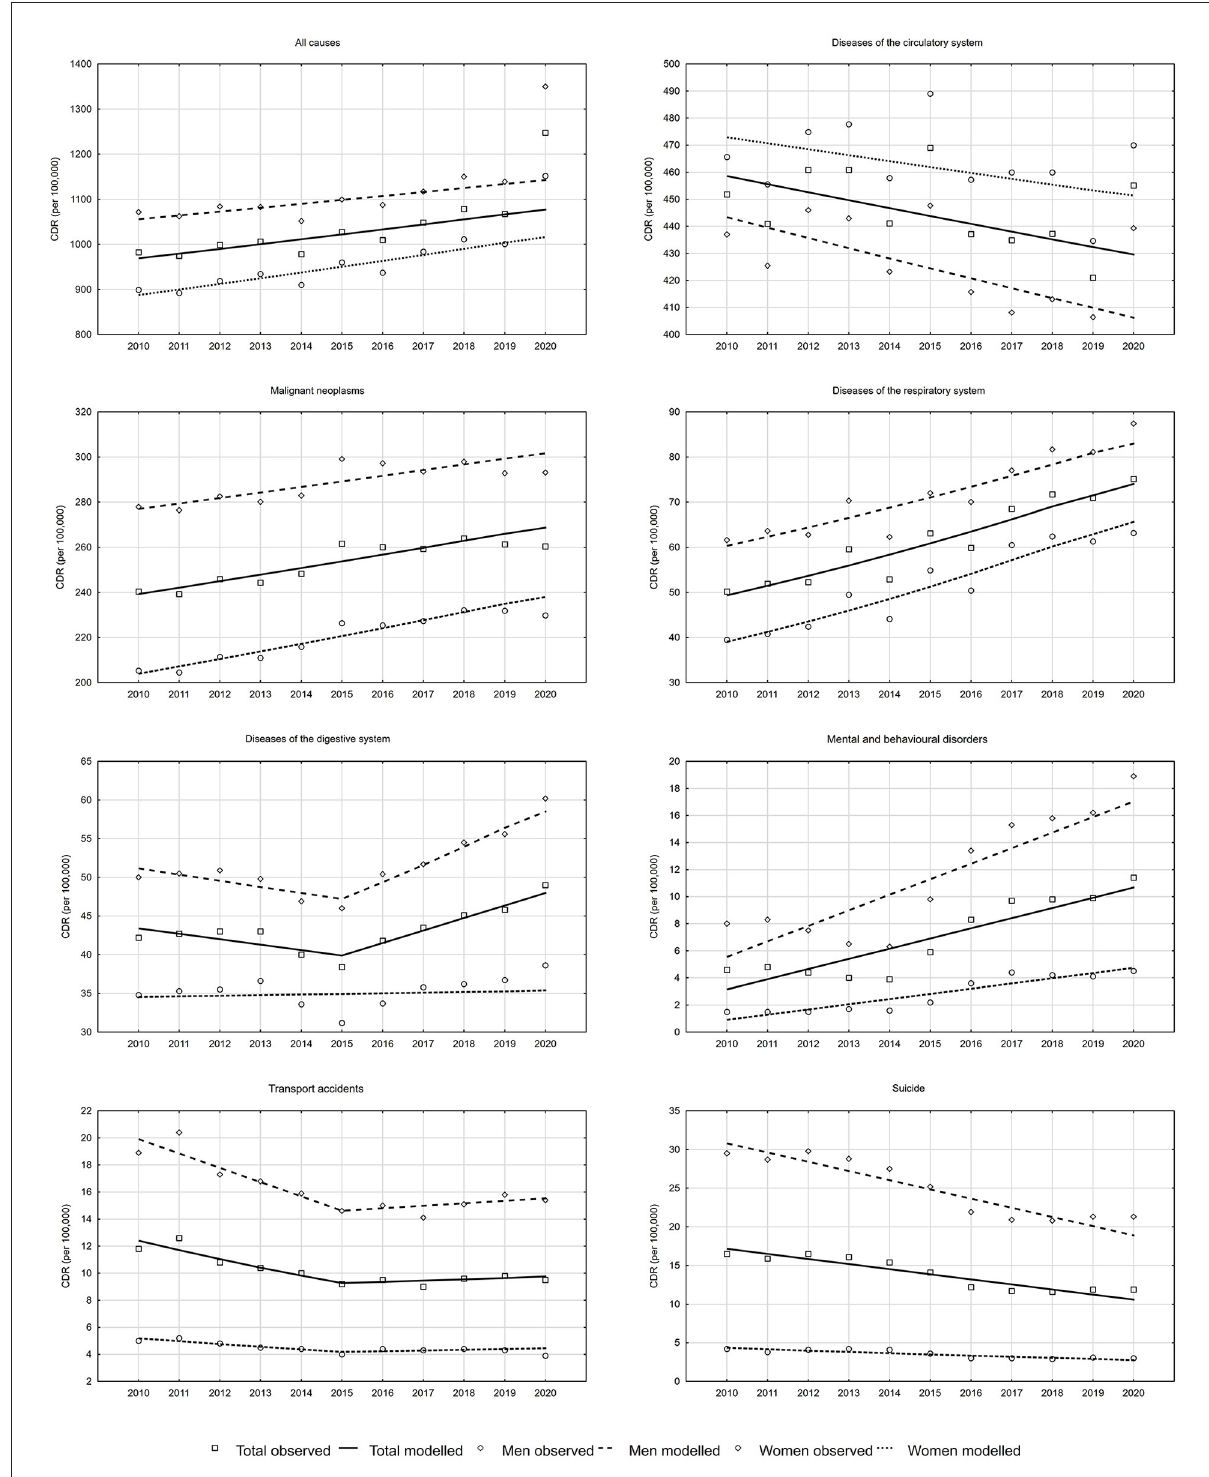
FIGURE1 Trends in crude death rates due to all causes and due to selected causes of death in the years 2010–2020 in